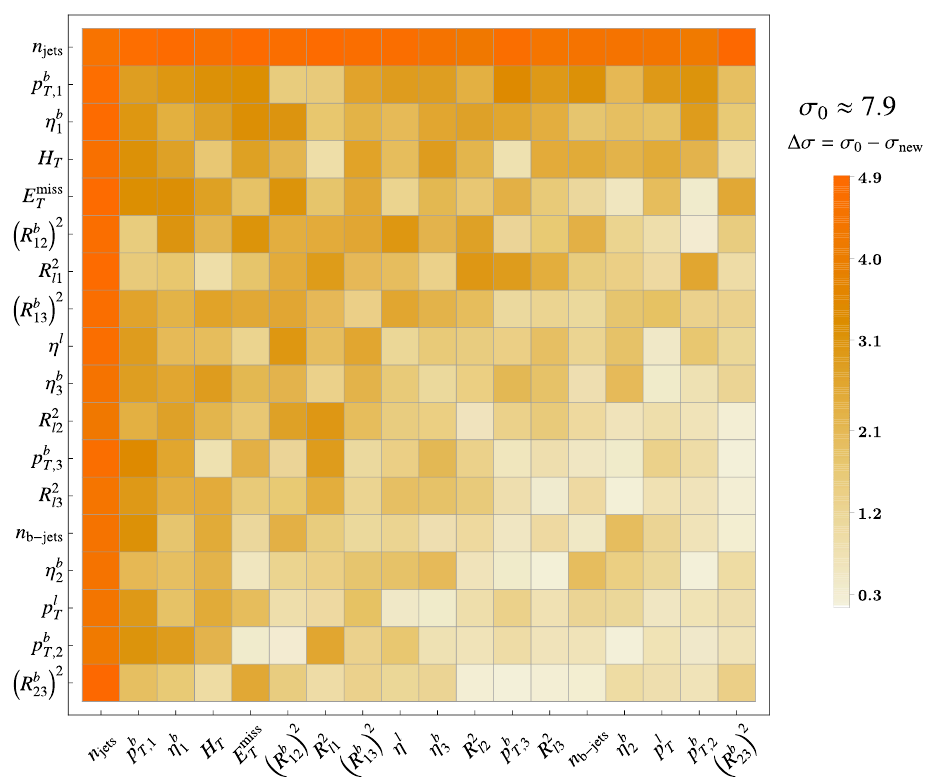
Figure 21 . Change in the significance ∆ Z when re-evaluating the BDT after performing the training without the variables listed on the axes. The diagonal elements correspond to dropping one training variable. The matrix is by construction symmetric. The significance using the whole set of variables is σ 7 . 9 0 ≈